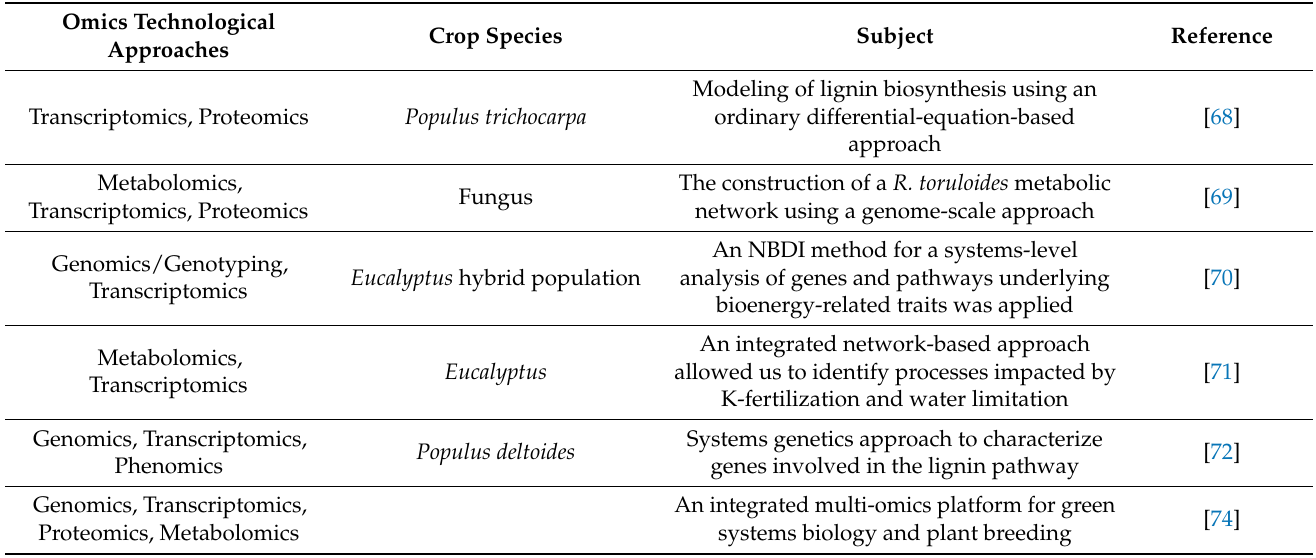
Table 5. Integration multi-omics data-based studies to improve biomass yield and